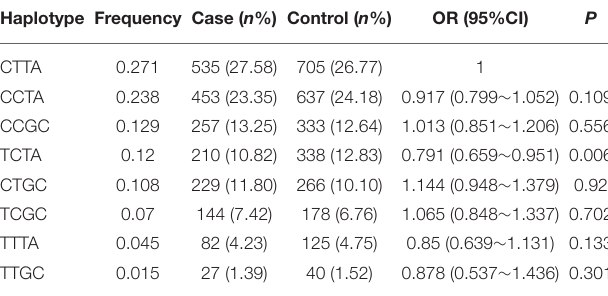
TABLE 4 | Frequencies of haplotypes (rs2297406-rs2472433-rs2472510-rs251 5614) among cases and controls and association with the risk of SBP. Haplotype Frequency Case ( n %) Control ( n %)